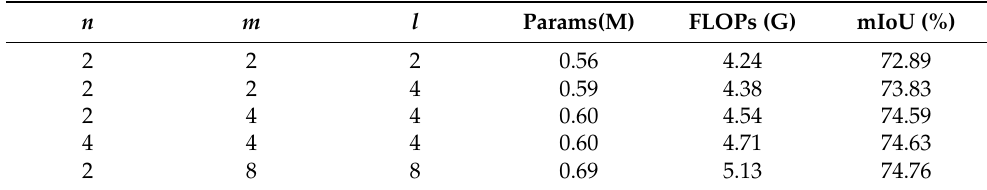
Table 5. Results of MVDNet with different depths; the number of parameters and FLOPs are estimated for a 512 × 512 input.